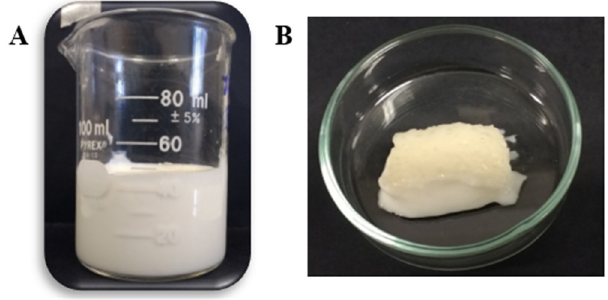
Figure A1. ( A ): Emulsion, ( B ): dried product before homogenization.